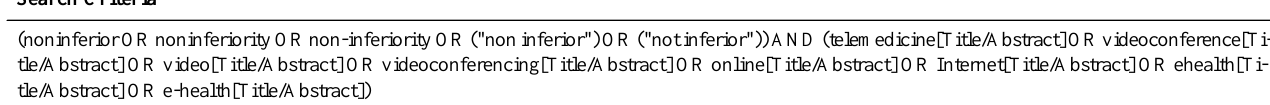
Table 1. Description of search criteria. Search